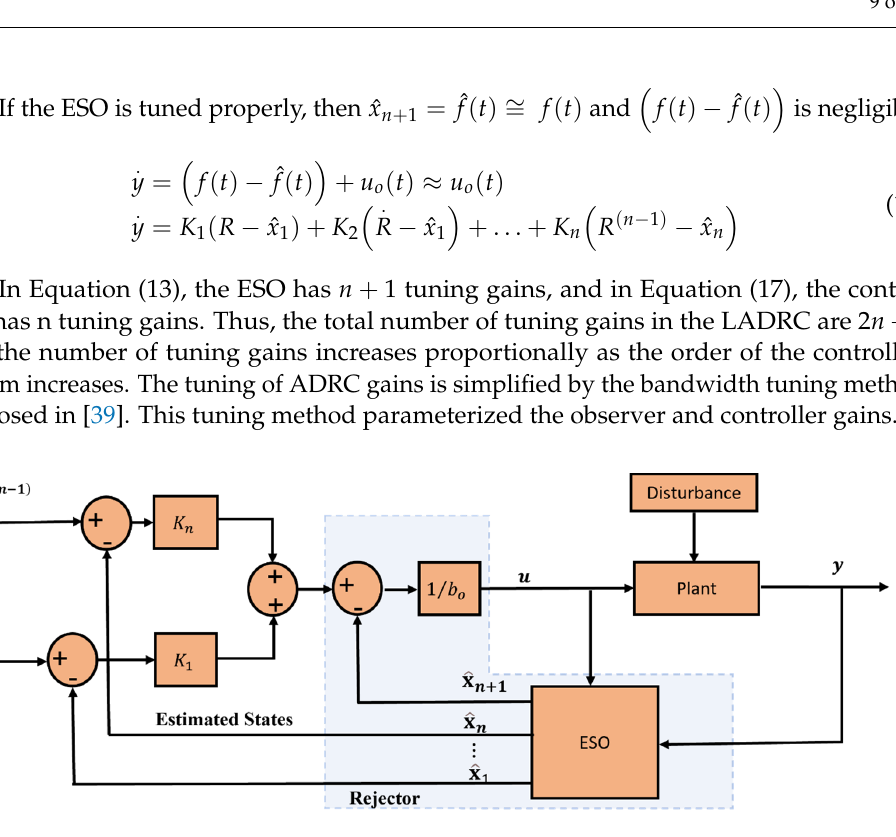
Figure 4. Block diagram of the general nth order LADRC.